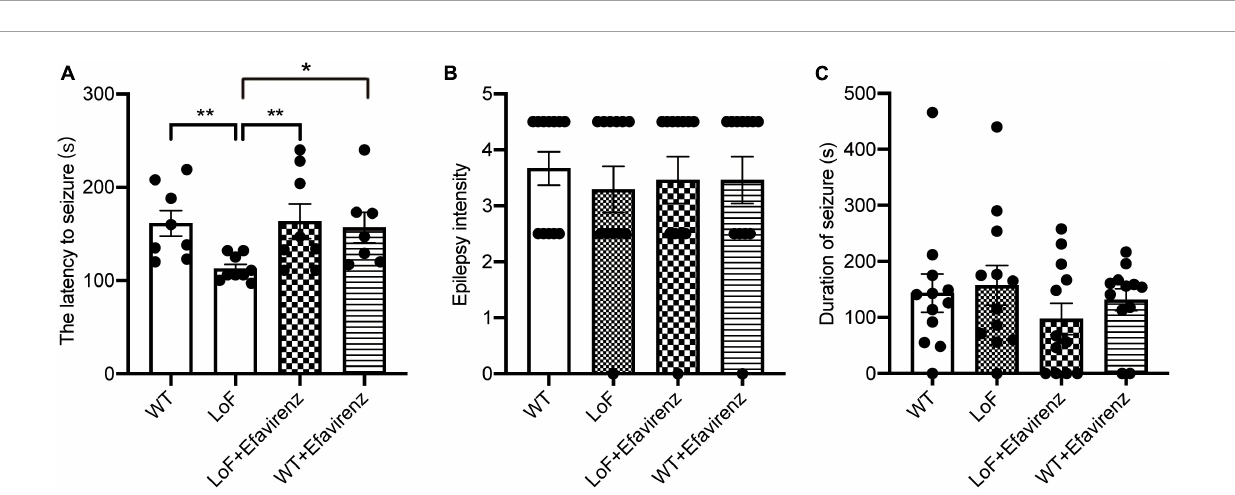
FIGURE2 The latency, intensity, and duration of seizure in mice induced hyperthermically. Mice were subjected to hyperthermic seizure test. The latency to seizure (A) , seizure intensity (B) , and seizure duration (from onset to the first return to normal and emergence of consciousness) (C) were recorded. * P < 0.05; ** P <